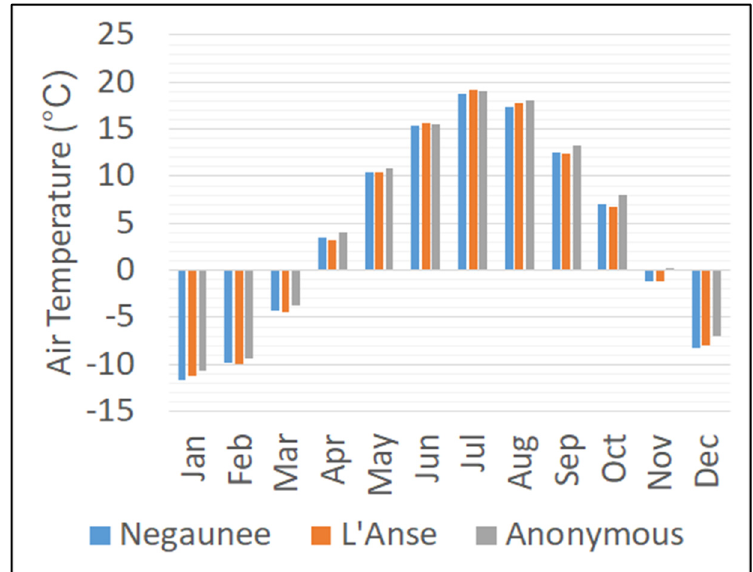
Figure 5. Average monthly air temperatures at each case study location.